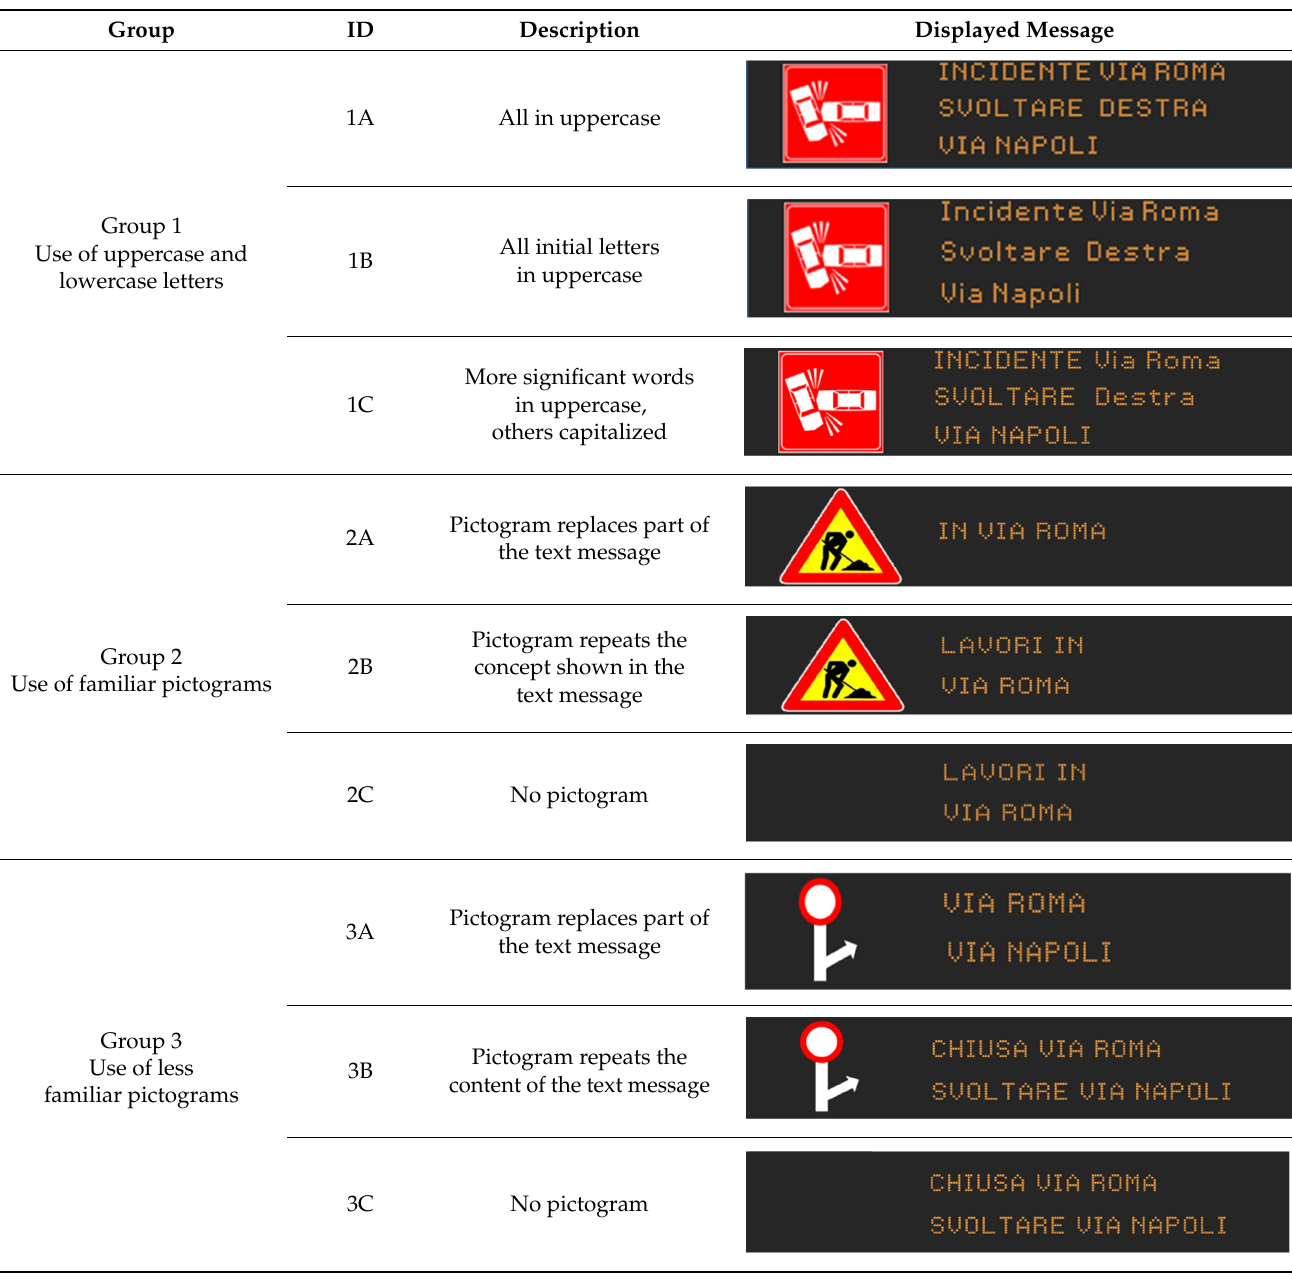
Table 2. Tested message Table 2. Tested message compositions. Table 2. Tested message compositions. Table 2. Tested message compositions. Table 2. Tested message compositions. Table 2. Tested message compositions. Table 2. Tested message compositions.